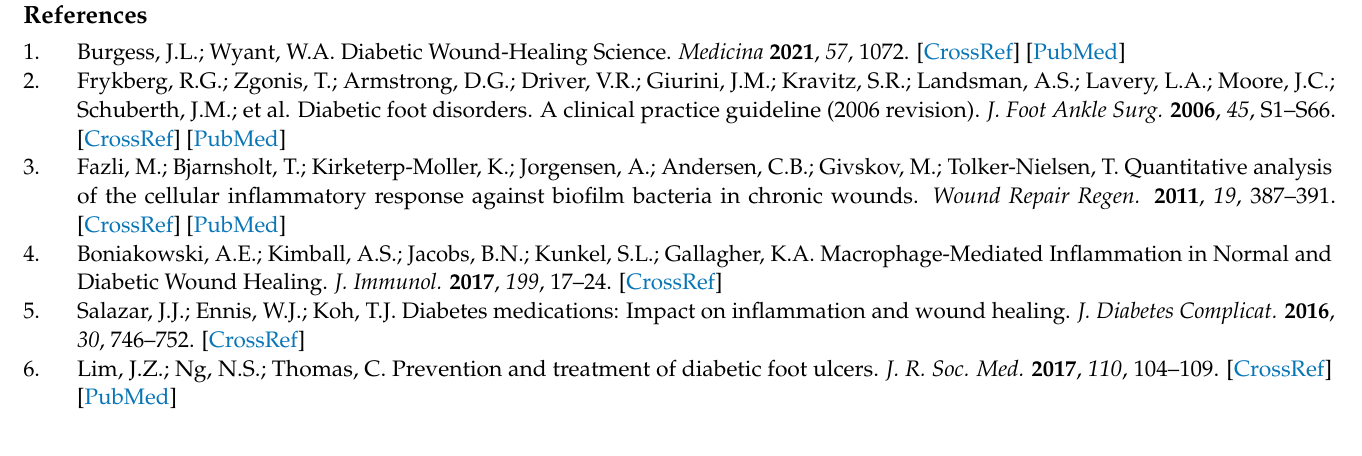
Figure S1. Elements analysis by scanning electron microscopy-energy dispersive X-ray spectrometry (SEM-EDS) of PP and PP/Qx samples (All results in weight %). Figure S2. A. Stress-strain curves of PP/Qx electrospun mats. B. Image of a sample during tensile testing at different elongation percentages. Figure S3. Morphological analysis of mats after immersion test: diameter distribution (left) and SEM micrographs (right) at different time intervals. Figure S4. ATR spectra of mats before (PP, Quercetin, PLA) and after (PP/Q10) immersion